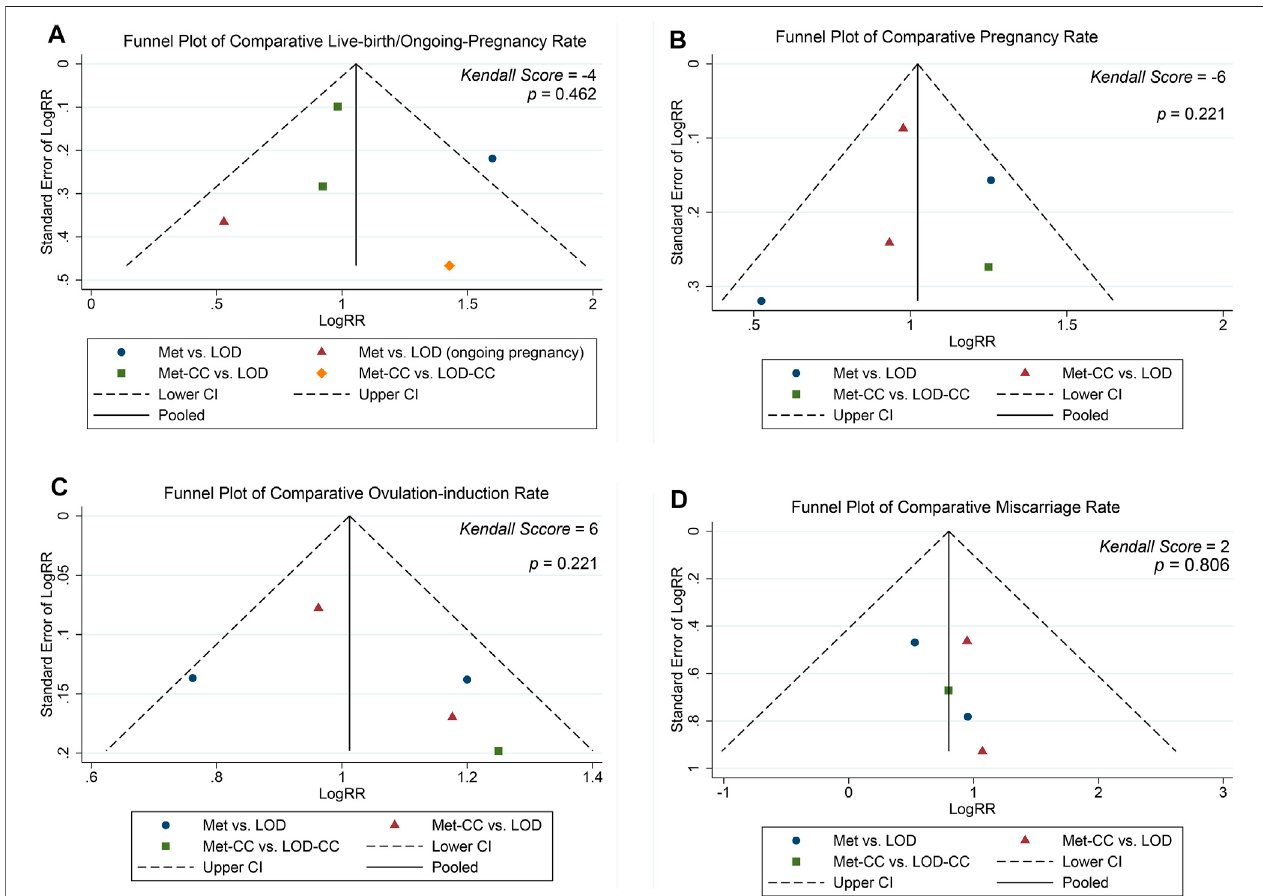
FIGURE 4 | Funnel plot of (A) live birth/ongoing pregnancy, (B) pregnancy (C) ovulation induction, and (D) miscarriage rates.